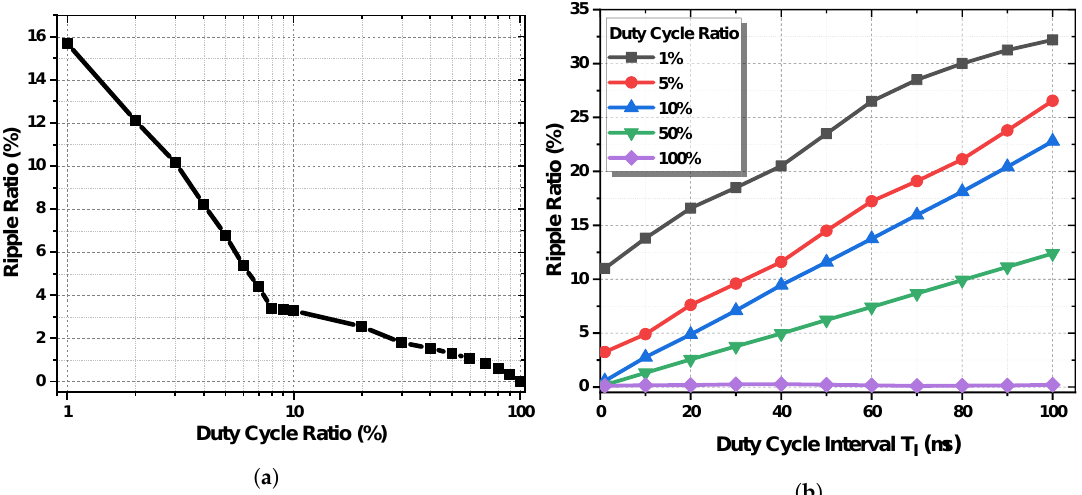
Figure 13. ( a ) Ripple ratios (RR) vs. the duty cycle ratio ( D ) at T I the duty cycle interval of 1 µ s. ( b ) RR vs. T I at 100%, 50%, 10%, and 1% of the duty cycle